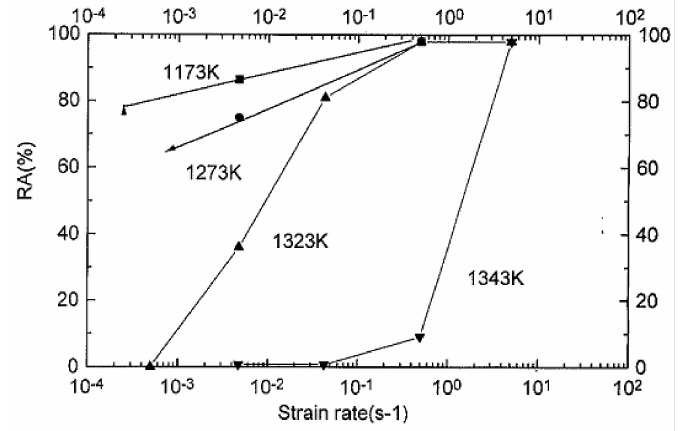
Figure 9. Strain rate dependence of hot ductility at different test temperatures for a C-Mn steel with Cu as impurity. Reprinted from ref. [9].